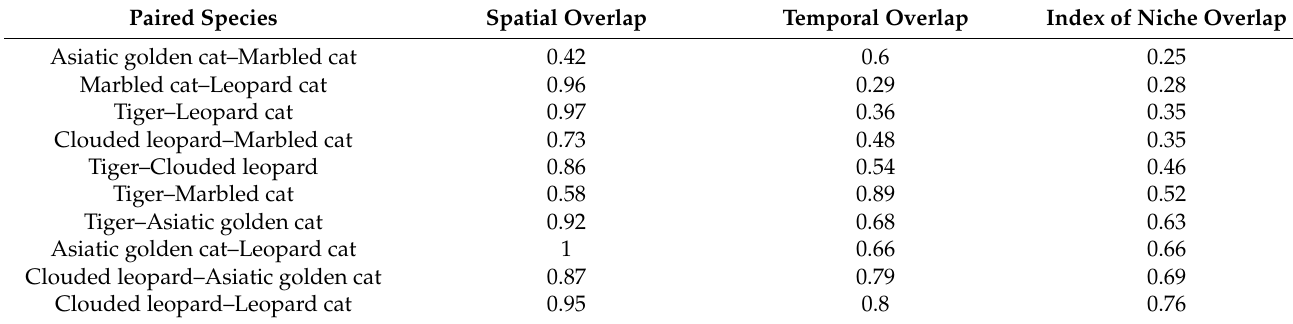
Table 2. Index of niche overlap: spatial, temporal, and multi-dimensional overlap (index of niche overlap as a multiplication of spatial and temporal overlap) between each pair of